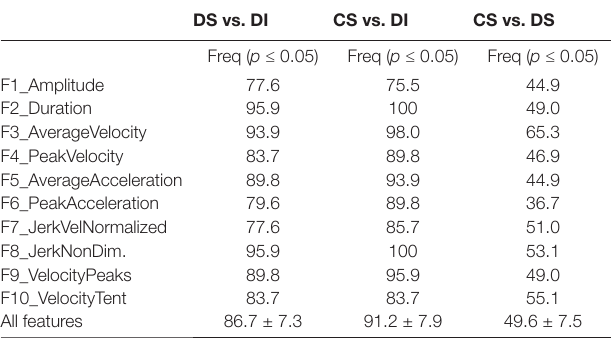
TaBle 6 | F test results between different model comparisons for each feature; within table: F =